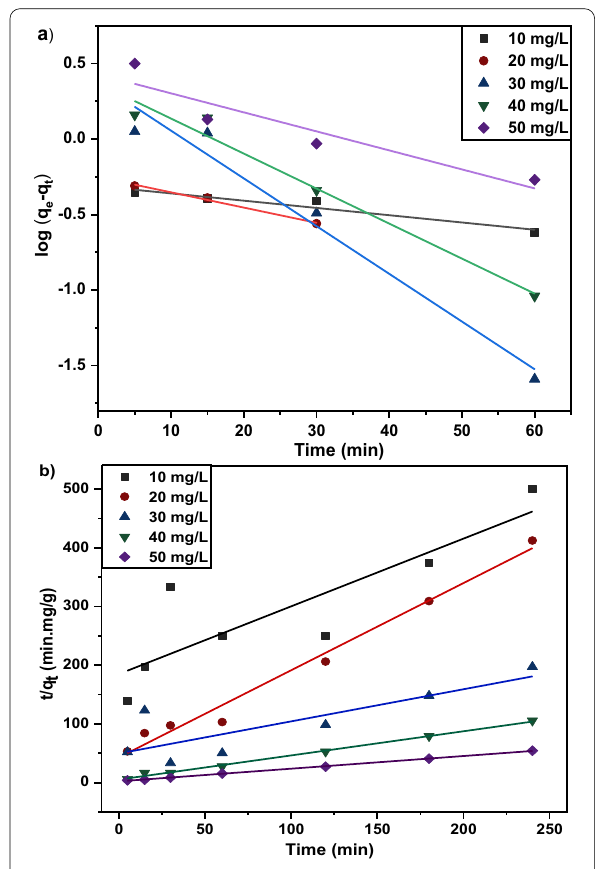
Fig. 14 a Lagergren’s first-order kinetic model; b Pseudo-second-order kinetic model for the removal of Cu (II) ions at various initial concentrations from the aqueous solution using MNA at 0.05 g/L dosage of MNA-7 h